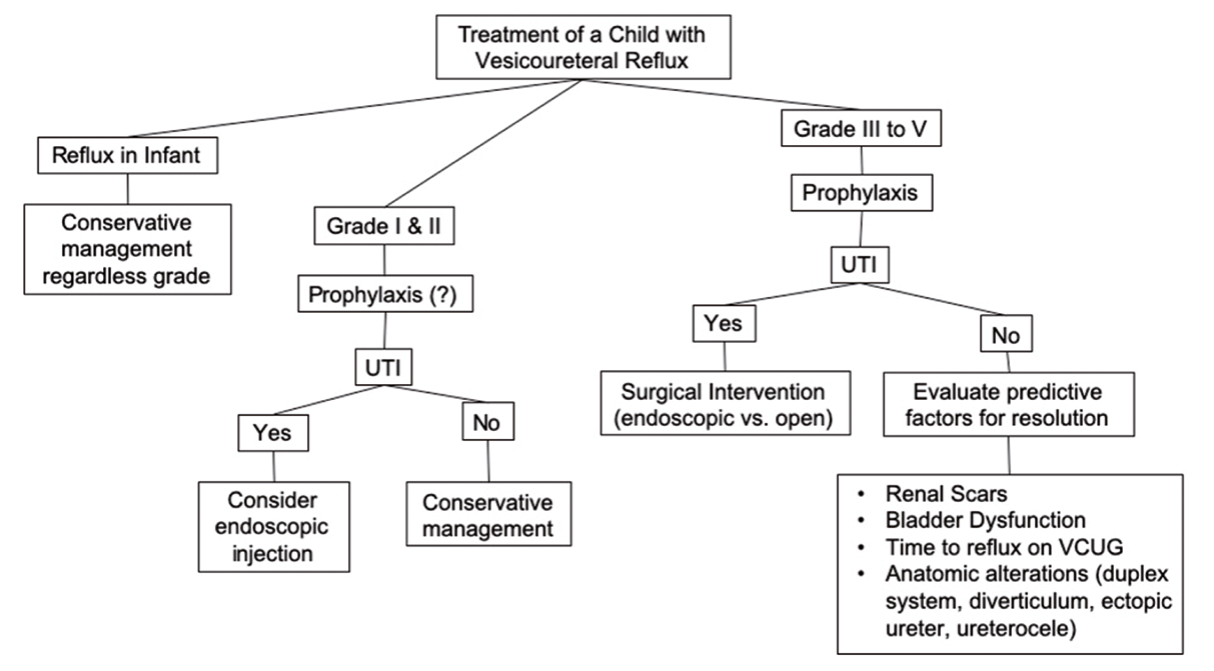
Figure 3 - Management of